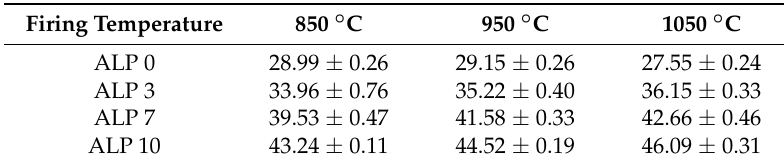
Table 4. Open porosity (%) of samples.